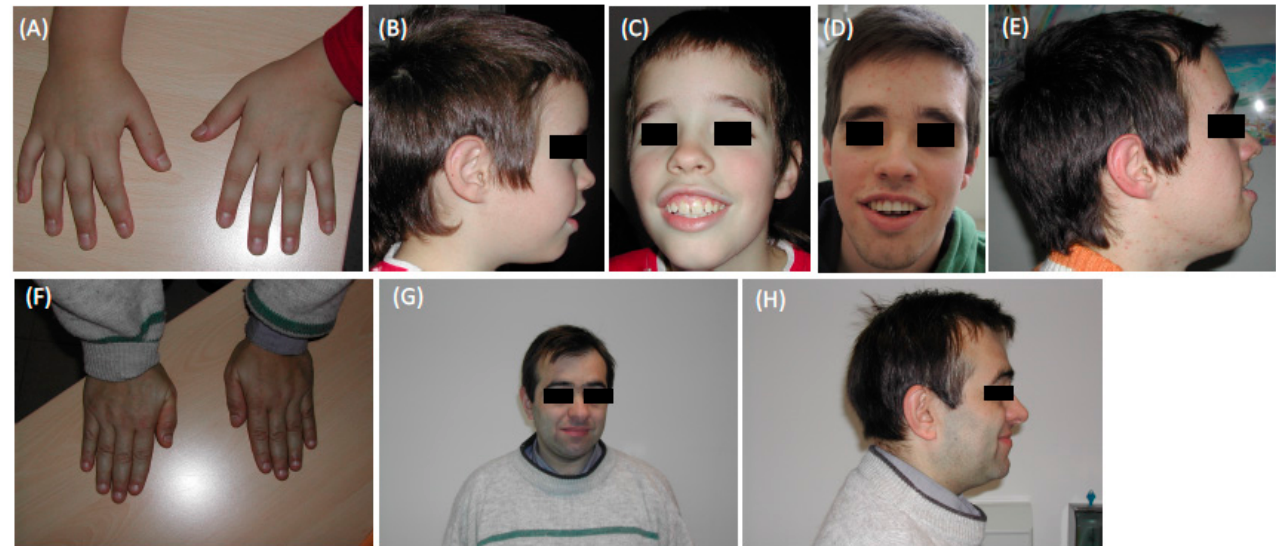
Figure 2. ( A – C ) Patient (III:1) 9 years old, ( A ) short hands with relatively long fingers, mild joint stiffness; ( D , E ) patient 17 years old. Note the course of dysmorphic features with age. Note high forehead, bitemporal narrowing, long face, telecanthus, down-slanting palpebral fissures, malar hypoplasia, wide mouth with the thick and everted upper and lower lip. ( F – H ) Uncle (II:3), note brachycephaly, round face, high forehead, hypertelorism, arched eyebrows with synophrys, deviated nasal septum, bulbous nasal tip with the low hanging columella, lower lip not thick and only slightly everted. (All photographs reproduced with permission).